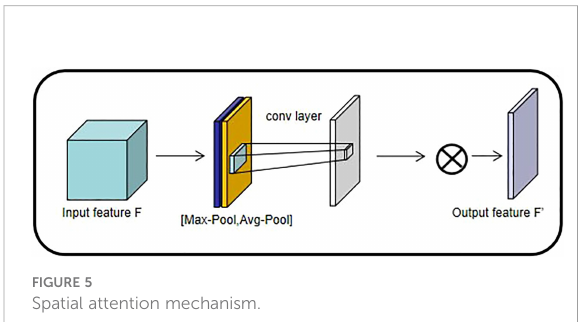
FIGURE 3 CBAM structure